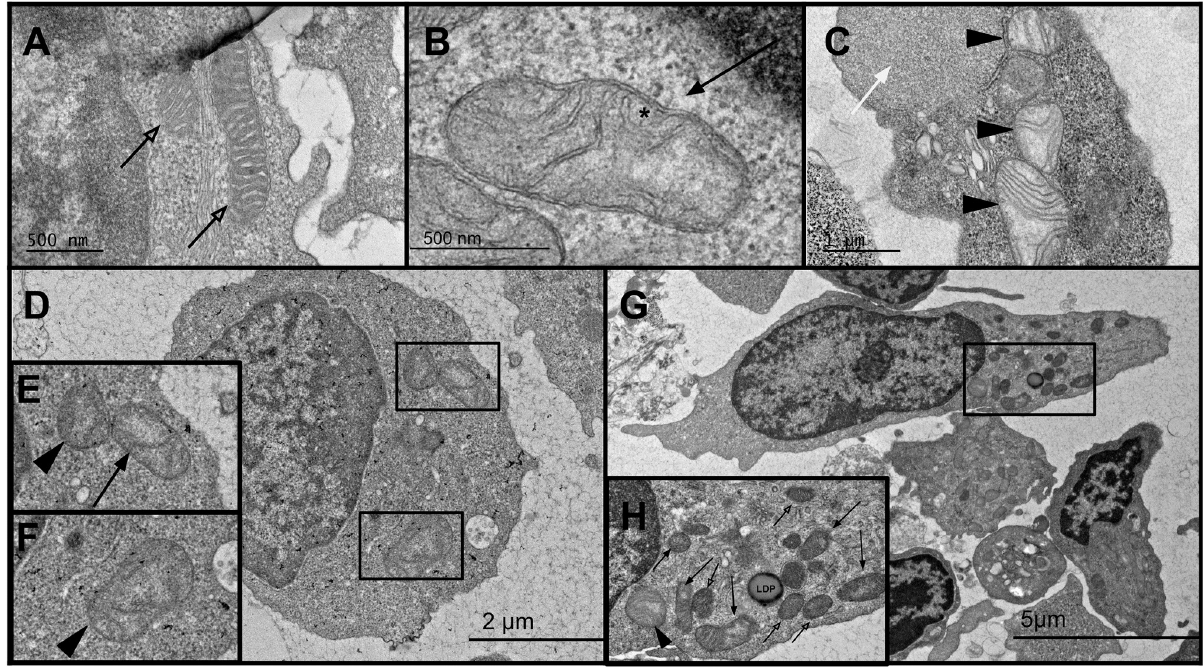
Fig 2. TEM analysis of the stimulated T cells to identify changes in mitochondrial morphology upon stimulation. A) A representative TEM image of normal mitochondria (open arrow), with dense staining of the inner matrix with an intact outer membrane at 10000x magnification. B) TEM image of a vesicular mitochondria (arrow) exhibiting an inner membrane enclosing separate vesicular matrix compartments ( � ) and rounded cristae at 10000x magnification. C) Displaying 3 swollen mitochondria (arrowhead), which show expanded matrix space and disorganized crista at 5000x magnification. Note a giant intracellular lipid droplet-like vesicle (white arrow) at the top-right corner. D) Representative image of several abnormal mitochondria within a single PBMC cell at 2000x magnification, E) zoomed in image of two abnormal MT within a cell, one vesicular and one swollen, F) zoomed in image of a swollen mitochondria. G) Representative image of the number of mitochondria found within a PBMC at single cell resolution at 1200x magnification, H) healthy, vesicular, and swollen mitochondria are all present within one single cell, as well as a lipid droplet-like vesicle